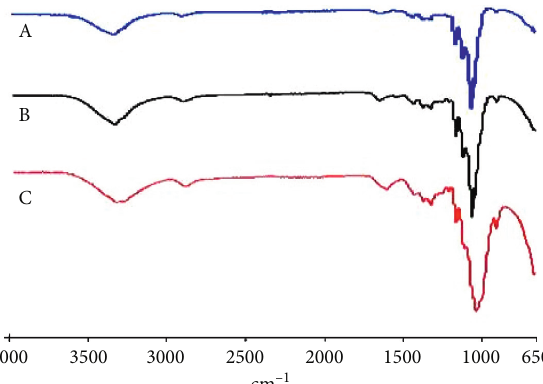
Figure 4: MFC/NFC aerogel FTIR spectra with chitosan 20%. Note: A, MFC aerogel 0% CH; B, MFC aerogel 20% CH; C, NFC aerogel 20% CH.